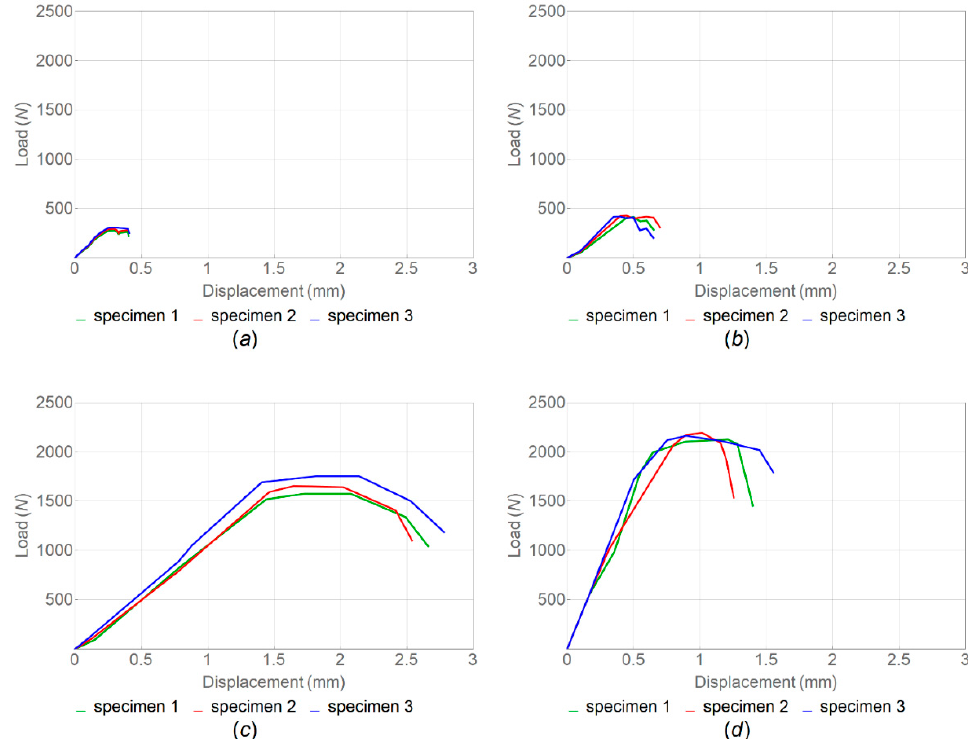
Figure 13. Load–displacement curves for PEEK samples printed with vertical ( a , b ) and horizontal ( c , d ) orientations (( a , c )—no heat treatment; ( b , d )—with heat treatment; and infill angle—90°). Table 6. Critical stress intensity factor, critical strain energy release rate and tensile strength obtained in CT